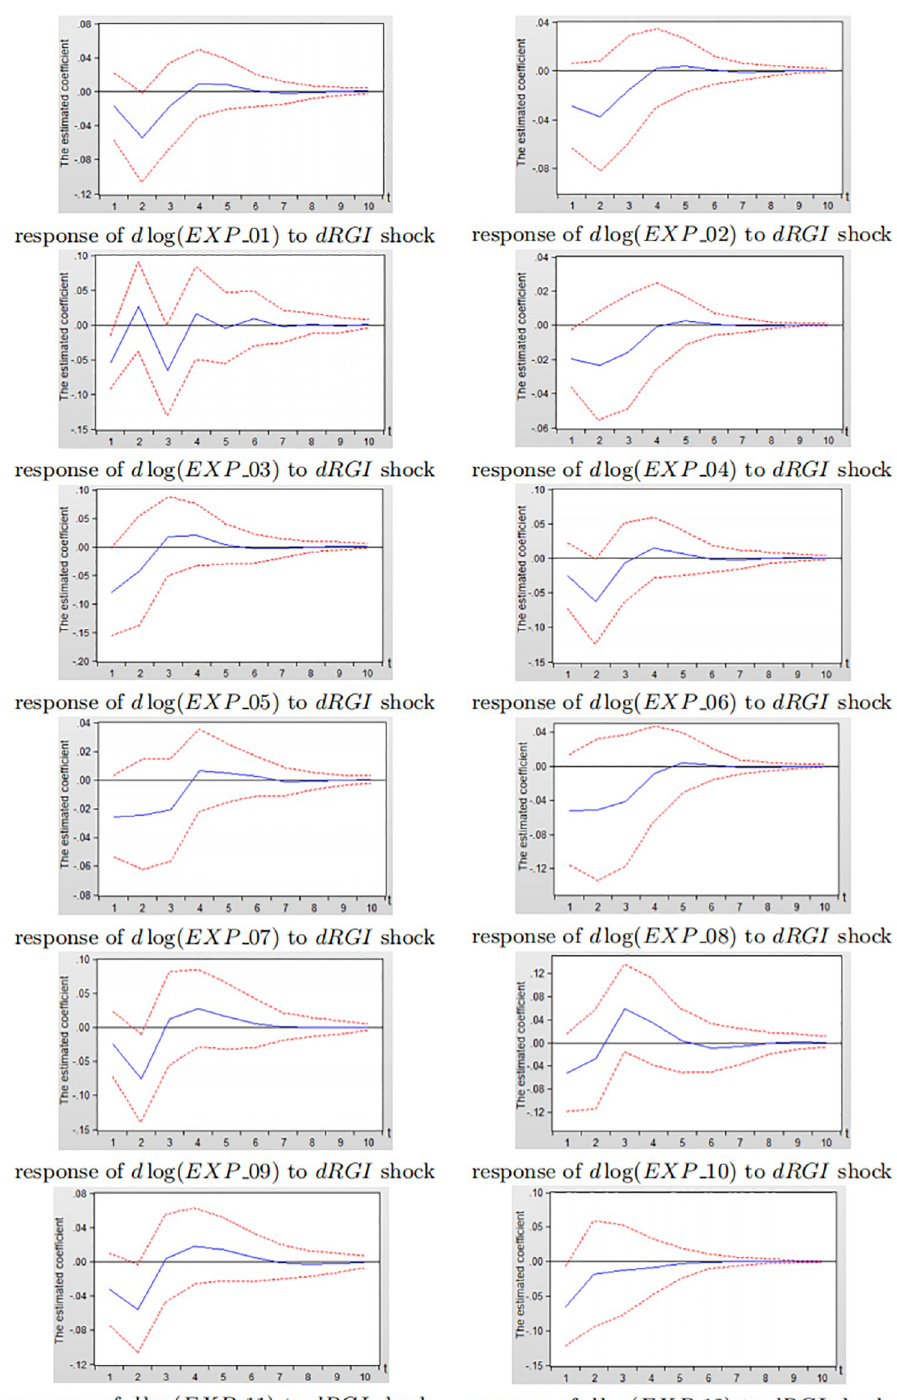
Fig 12. Impulse response diagram of reverse globalization to China’s subdivided manufacturing exports.